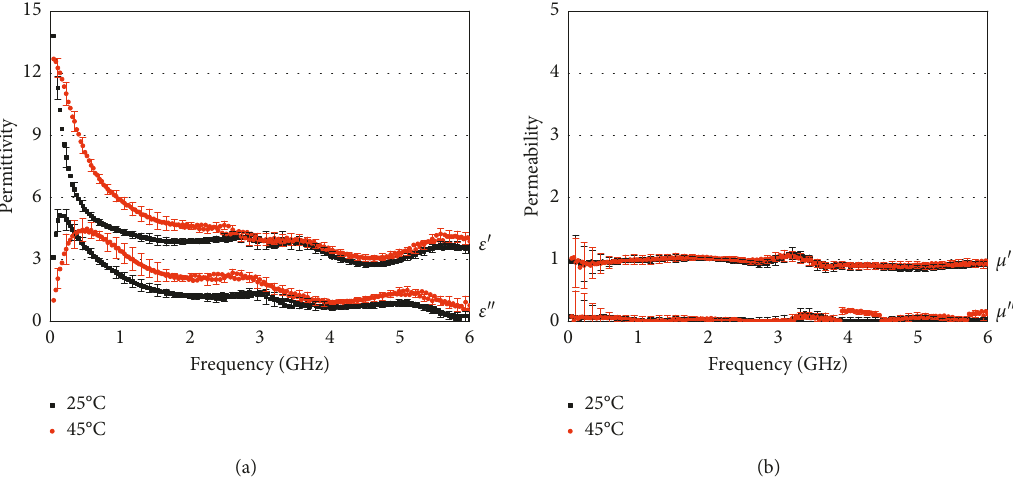
Figure 7: Real part and imaginary part of permittivity (a) and permeability (b) of a sample of cyclohexanol with frequency and temperature variations with the corresponding error. The frequency range is from 50MHz to 6GHz at two different temperatures, 25 ° C and 45 °